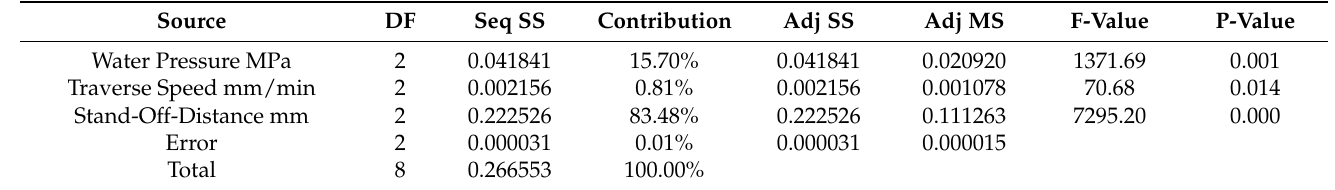
Table 18. ANOVA table for kerf taper angle response of input cutting parameters of 2 mm thickness of SPF-UPE composite cut with abrasive water jet technique.